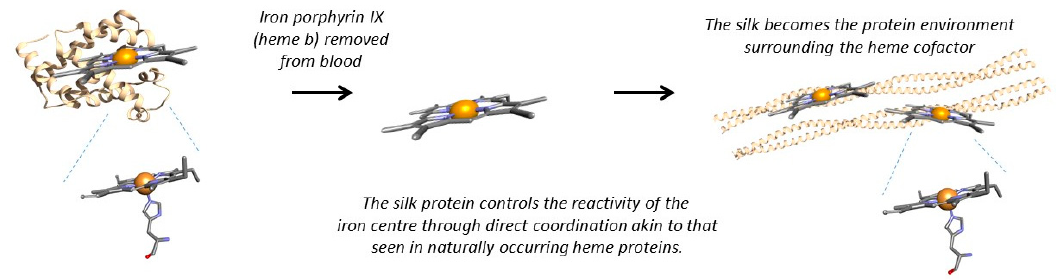
Figure 2. Scheme demonstrating how the silk protein replaces the heme protein scaffold to produce a silk based metalloprotein. The silk protein not only immobilises the heme cofactor but controls the reactivity of the metal centre via direct coordination of a histidine residue.